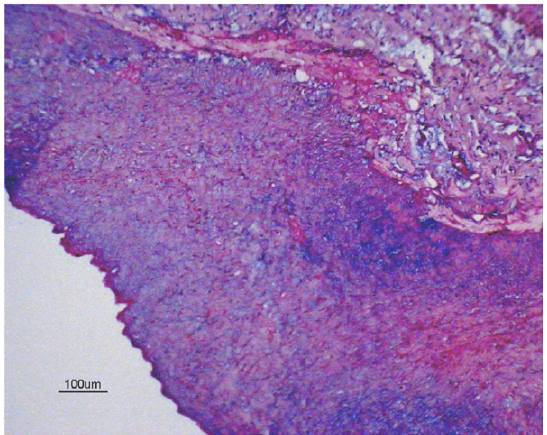
Figure 1. Severe irregular endocardial thickening is shown in photomicrography of a ventricle affected by advanced endomyocardial fibrosis (10X Alcian Blue). Clinical picture and